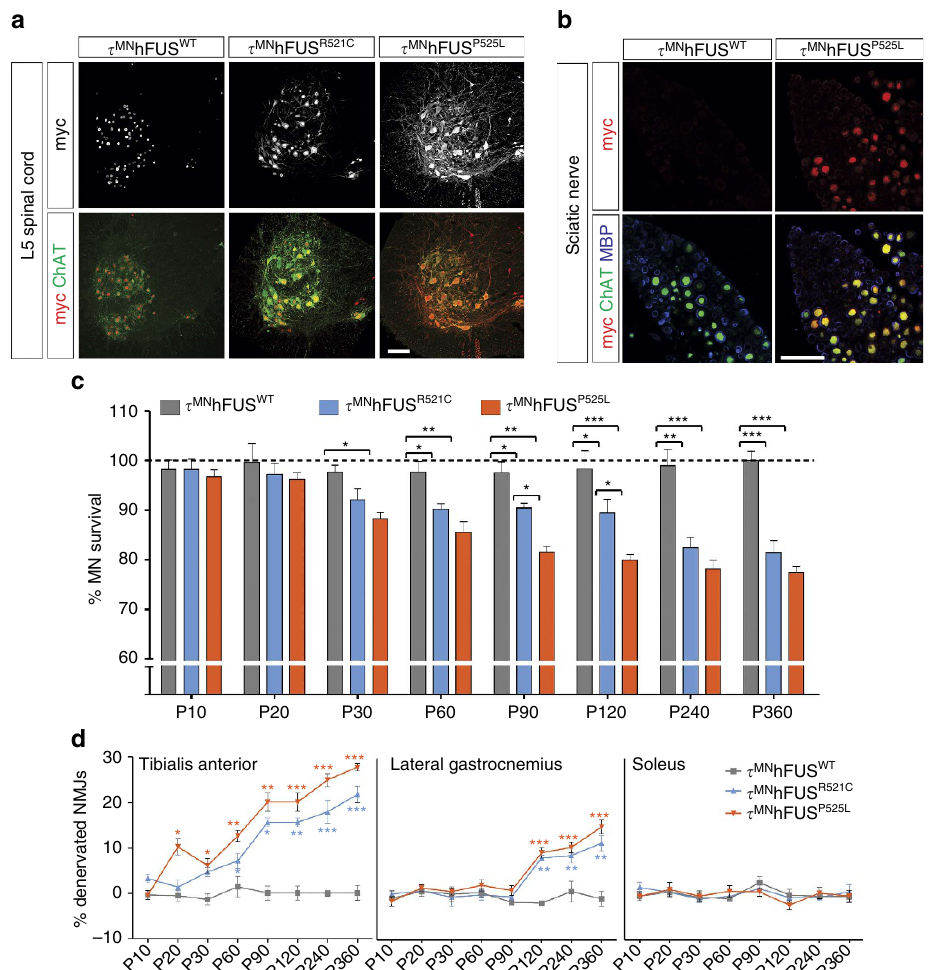
Figure 5 | Motor neuron-selective expression of mutant FUS results in degeneration of MNs and denervation of fast muscles. ( a ) Conditional expression of myc-tagged hFUS proteins (grey, top) in cholinergic cells of t MN hFUS WT , t MN hFUS R521C and t MN hFUS P525L animals. hFUS expression was restricted to cholinergic cells, as determined by the co-localization of myc (red, bottom) with ChAT (green, bottom). Scale bar, 100 m m. ( b ) Cross-sections of the sciatic nerves from t MN hFUS WT (left) and t MN hFUS P525L (right) animals stained with anti-myc (red), anti-ChAT (green) and anti-MBP (blue) antibodies. Co-localization of hFUS and ChAT in motor axons (yellow) was observed in t MN hFUS P525L but not in t MN hFUS WT animals. Scale bar, 20 m m. ( c ) MN survival in t MN hFUS WT (light grey), t MN hFUS R521C (light blue) and t MN hFUS P525L (orange) animals calculated from the number of MNs in the L5 spinal cord normalized to that of non-transgenic wild-type controls (expressed as a percentage). ( d ) Percentages of denervated NMJs in the tibialis anterior, gastrocnemius and soleus muscles of t MN hFUS WT (light grey), t MN hFUS R521C (light blue) and t MN hFUS P525L (orange) animals normalized to non- transgenic wild-type controls. (For c and d : * P o 0.05, ** P o 0.01 and *** P o 0.001 using one-way analysis of variance at each time point with Bonferroni’s post hoc test. Error bars represent s.e.m. N ¼ 4 for all